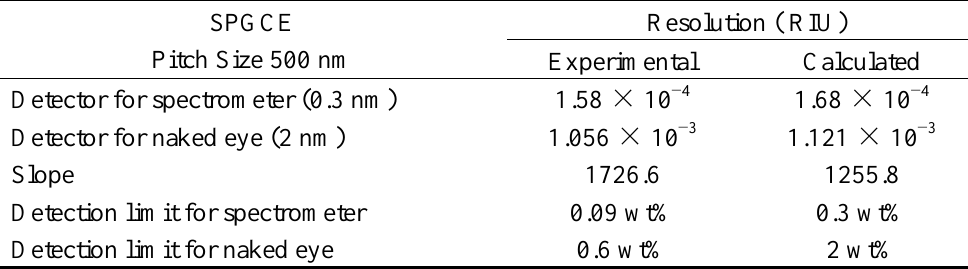
Table 2. Performance of the resolution for the organic plasmon-emitting